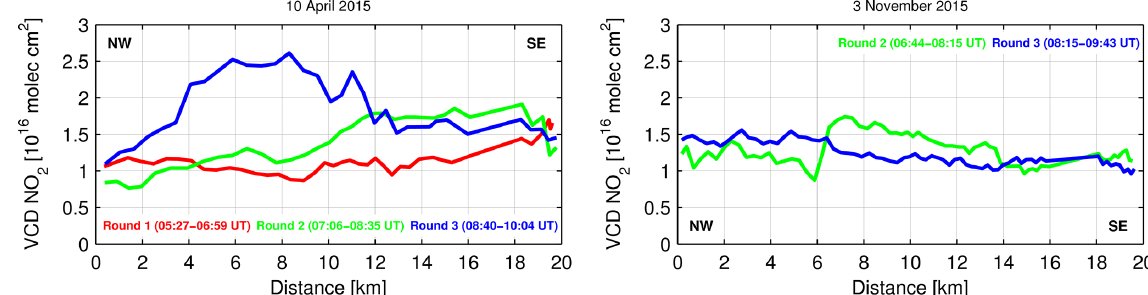
Figure 11. Temporal evolution of tropospheric NO 2 for the car DOAS zenith-sky measurements as performed on 10 April and 3 Novem- ber 2015. The red, green, and blue curves represent NO 2 VCD tropo as obtained along the A22 during the first, second, and third journeys,